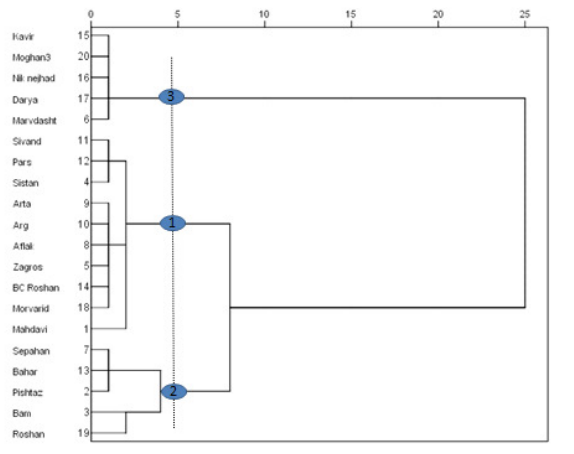
Fig. 1. Dendrogram obtained based on the factors obtained under normal irrigation